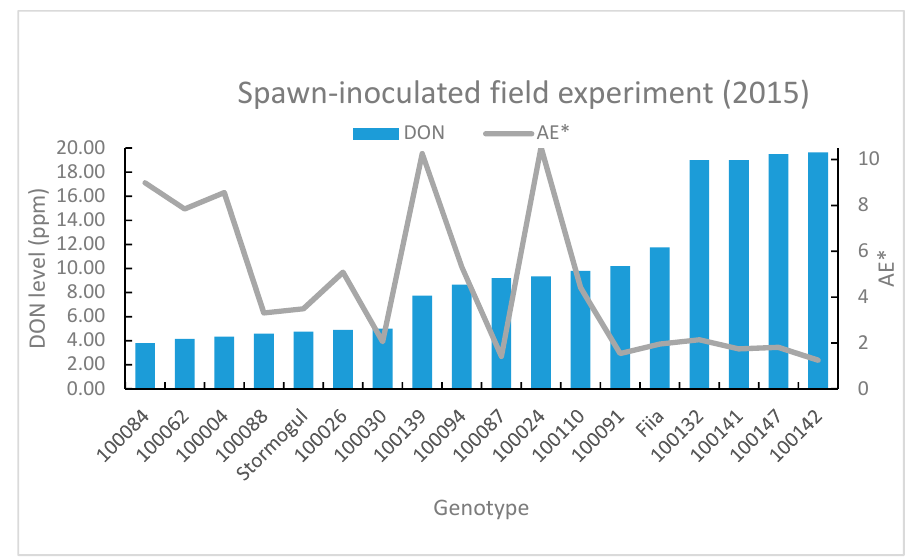
Figure 4. Mean deoxynivalenol content (DON and anther extrusion (AE*, estimated from average number of remaining anthers (AR) using the formula AE = 2.71 (3-AR) ) in a spawn-inoculated field experiment using selected recombinant inbred lines from the Fiia by Stormogul population and the parents.